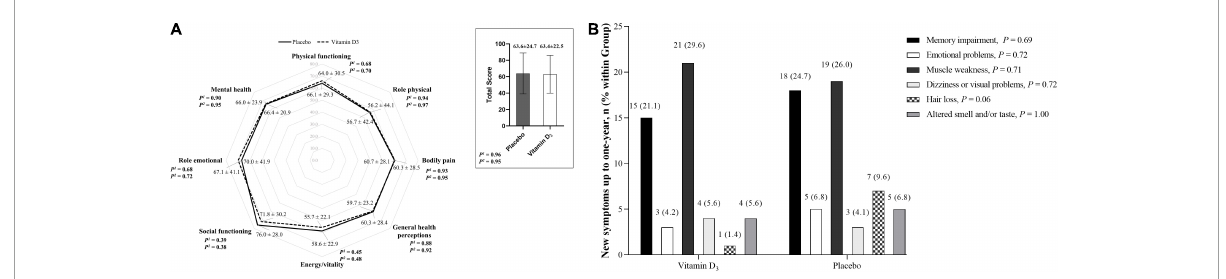
FIGURE1 Quality of life and new symptoms related to COVID-19. (A) Quality of life was assessed using the 36-Item Short Form Health Survey (SF-36) at 6 months. Values are mean ± SD. Data were analyzed using an independent T -test and generalized estimating equations (GEE) with normal distribution and identity link function with the first-order autoregressive correlation matrix. 1 P -value represents a 2-tailed independent t -test comparison. 2 P -value represents the main effect of the group adjusted by the length of hospital stay. (B) Frequency of new symptoms from hospital discharge to 1 year of follow-up. Values are n (% within the group). Proportions were compared between groups using chi-square tests ( χ 2 ). New symptoms were missing for 11.8% of patients ( n = 9 in the placebo group and n = 8 in the vitamin D 3 group) due to a lack of contact during